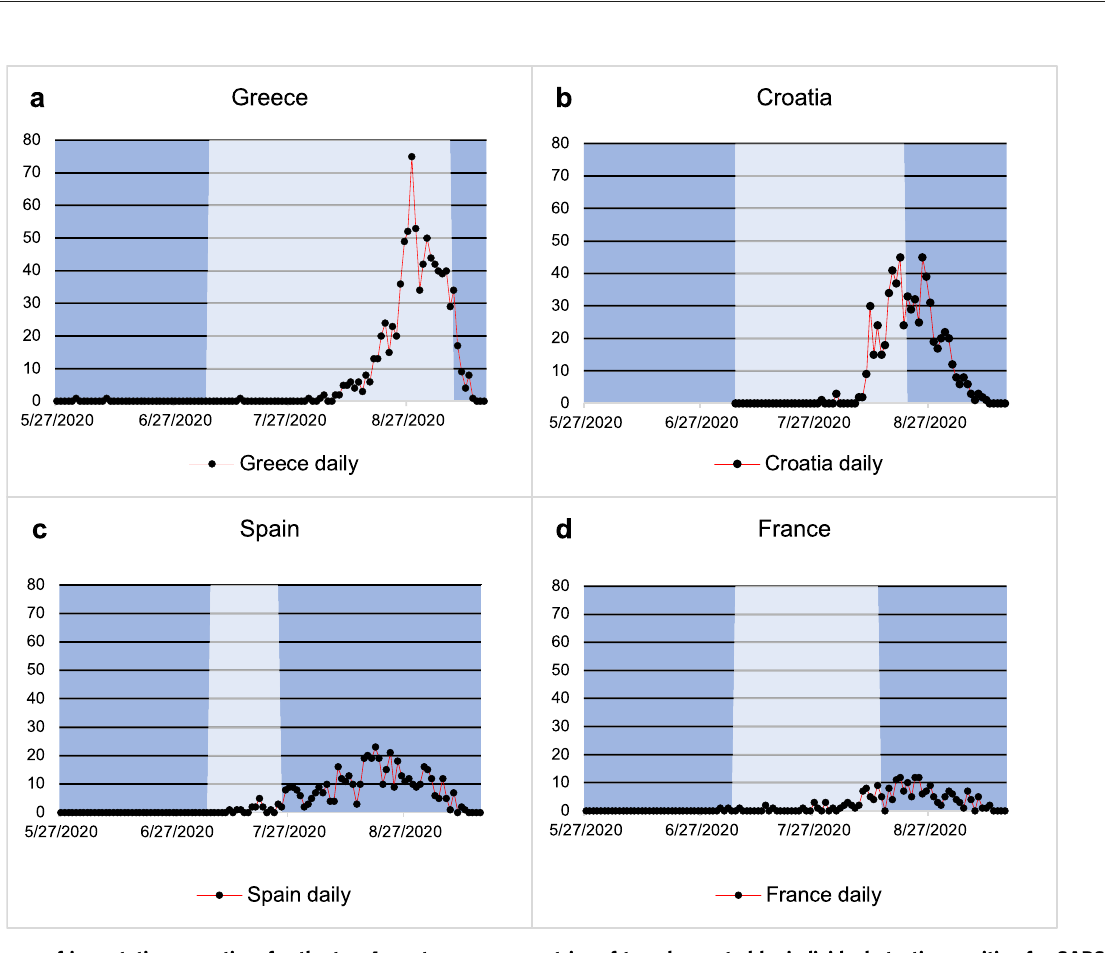
Fig. 2 Frequency of importations overtime for the top 4 most common countries of travel reported by individuals testing positive for SARS-CoV-2 during the study period. a – d SARS-CoV-2 case numbers in returning travellers by the four most popular countries of travel reported by cases representing 2379/4207 (56.5%) of known travel-related cases. The light-shaded areas represent the period of time when the countries had an open ‘ travel-corridor ’ so did not have mandatory 14-day quarantine on return in